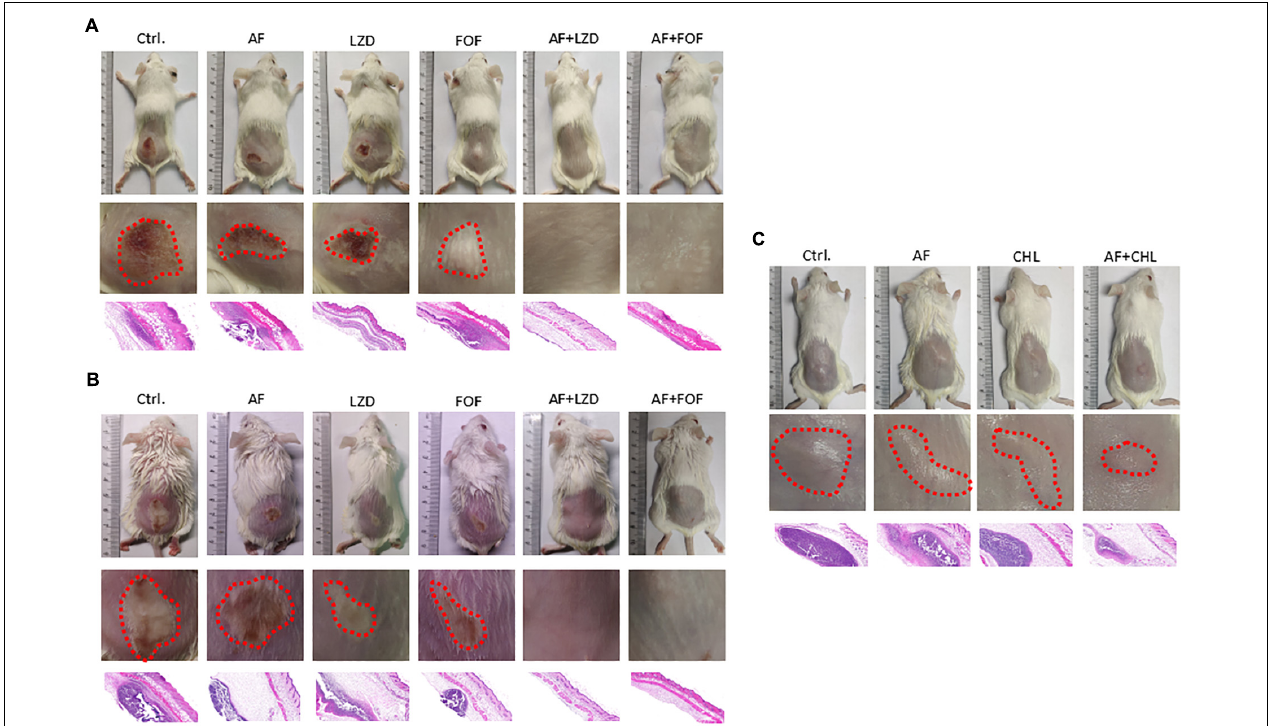
FIGURE 6 | Representative photographs of the cutaneous abscess in the presence/absence of AF and antibiotic mono- or combinatorial therapy. An entire dorsal back (upper panels) and close-up images of the abscess (red circle, middle panel) and representative histological results (H&E stain, 50 × , down panels) are shown at 2 days after therapy for (A) S. aureus LZB1, (B) S. aureus ATCC43300, and (C) E. faecalis